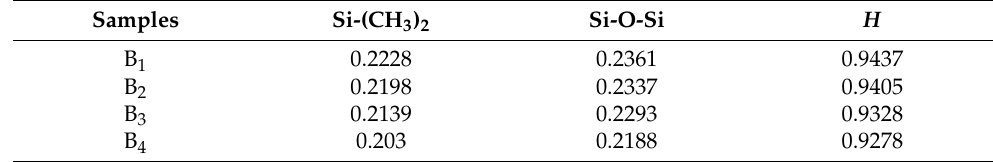
Table 4. The absorption peak height ratio of Si-O-Si and Si(CH 3 ) 2 of composite insulator in B.